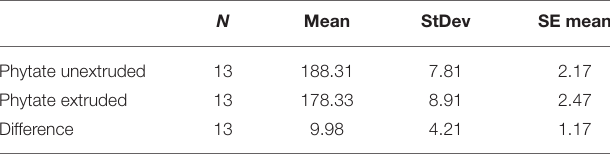
TABLE 4 | Condensed tannin contents of extruded and unextruded composite